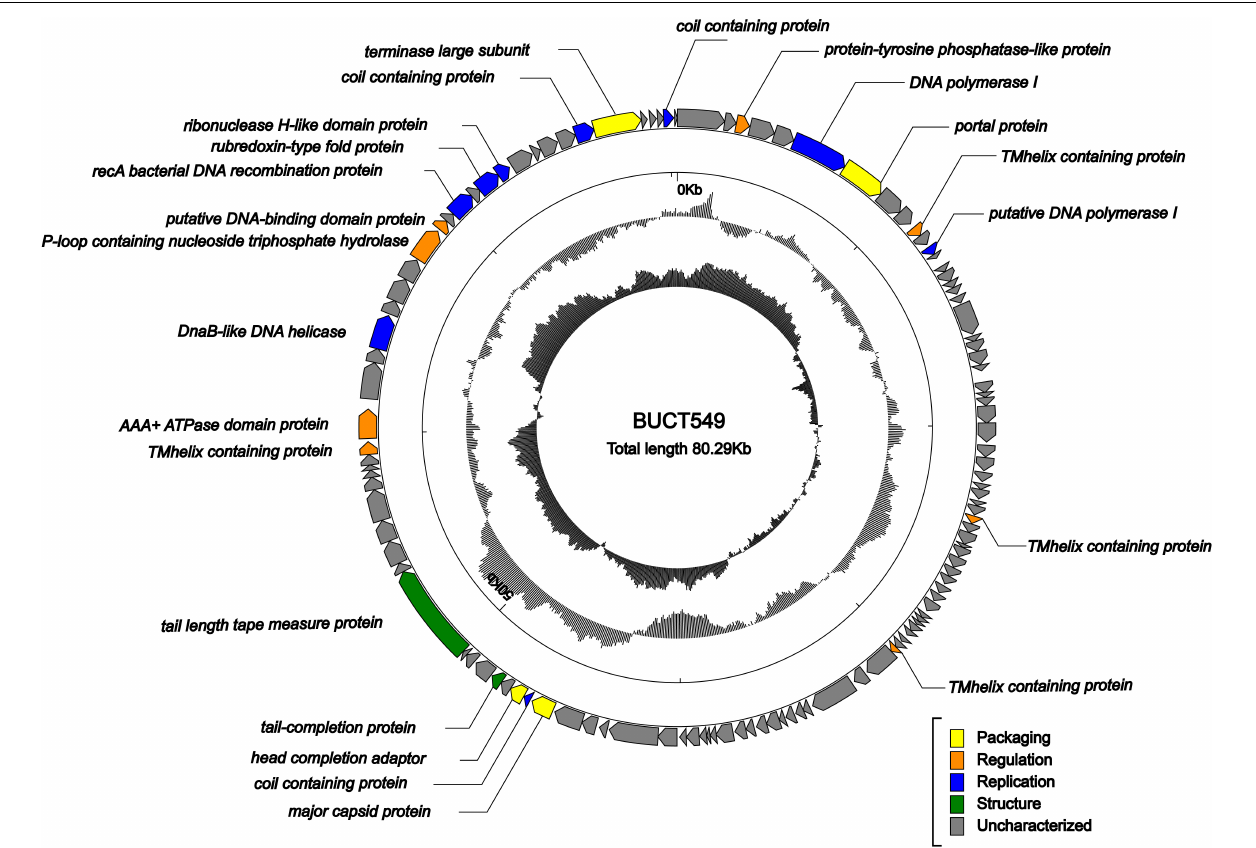
FIGURE 6 | Genome map of BUCT549. The outermost circle represents ORFs encoded in the genome with different colors representing different functions (clockwise arrow indicates the forward-reading frame, counterclockwise arrow indicates the reverse reading frame); the dark circles in the middle represent the GC content (outward indicates greater than the average GC content compared with the whole genome, and inward indicates the opposite); the innermost circle represents the GC skew (G–C/G + C. Outward indicates > 0 and inward indicates < 0).